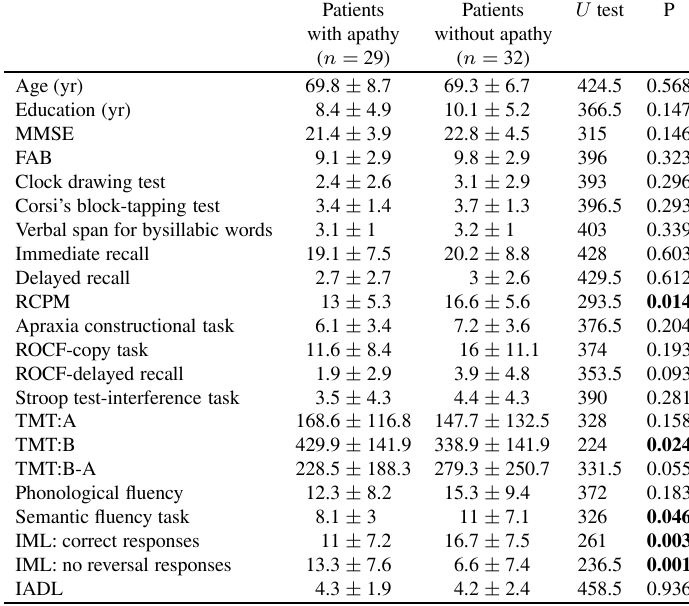
Table 2 Demographic and clinical characteristics of patients with and without apathy Patients Patients U